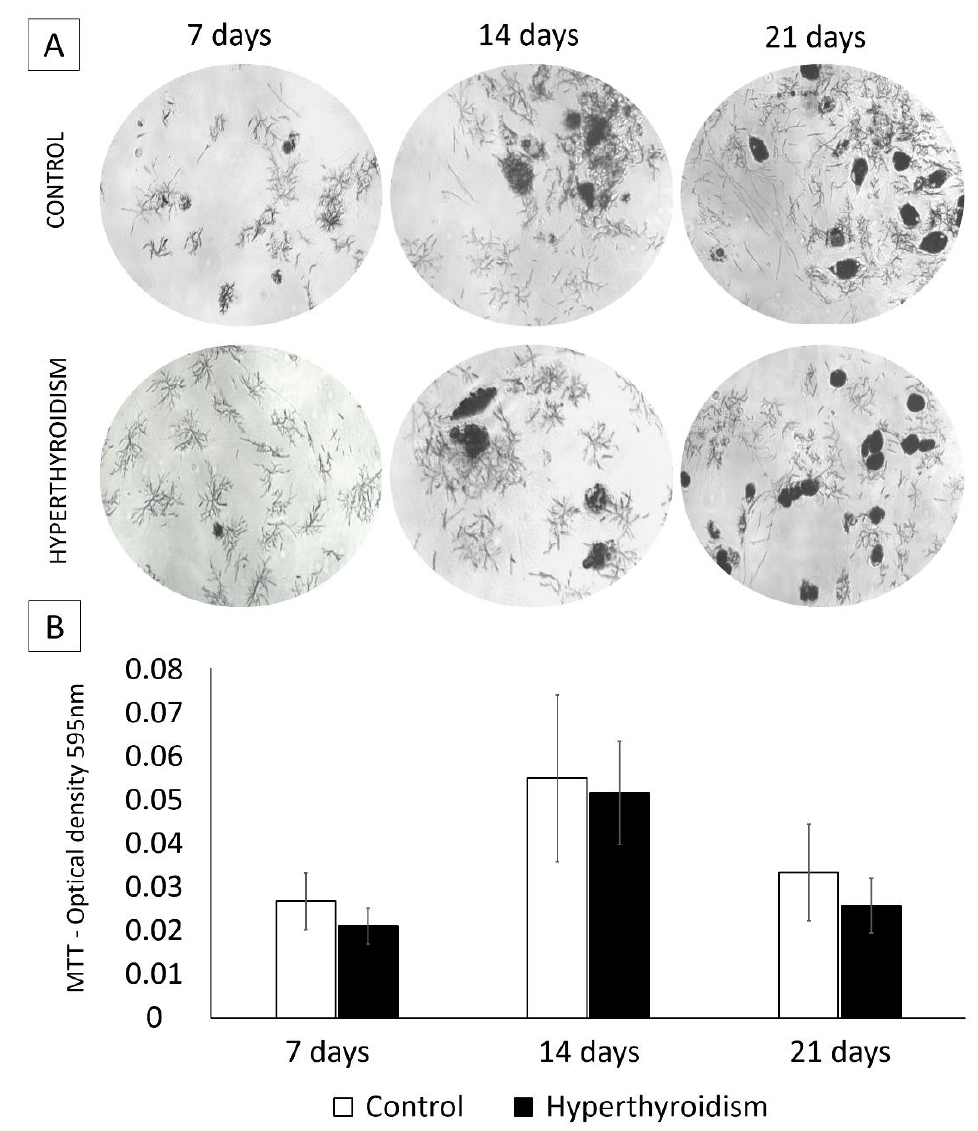
Figure 3. ( A , B ) Conversion of MTT to formazan crystals (mean ± standard deviation) in two-dimensional cultures of chondrocytes derived from the femoral epiphysis of control newborn rats and those exposed to maternal hyperthyroidism at 7, 14 and 21 days. Magnification: 25 × . 2.4. Maternal Hyperthyroidism Reduces Glycosaminoglycan Synthesis by Offspring Chondrocytes In both groups, chondrocytes were found to be located in gaps of varying sizes, surrounded by a cartilaginous matrix, with PAS+ and PAS − areas. In addition, the mor- phological characteristics of chondrocytes in terms of size, cytoplasm, and nucleus were similar between both groups. However, chondrocyte pellets from neonates exposed to maternal hyperthyroidism showed a significant reduction in the percentage of PAS+ areas when compared with the control (Figure